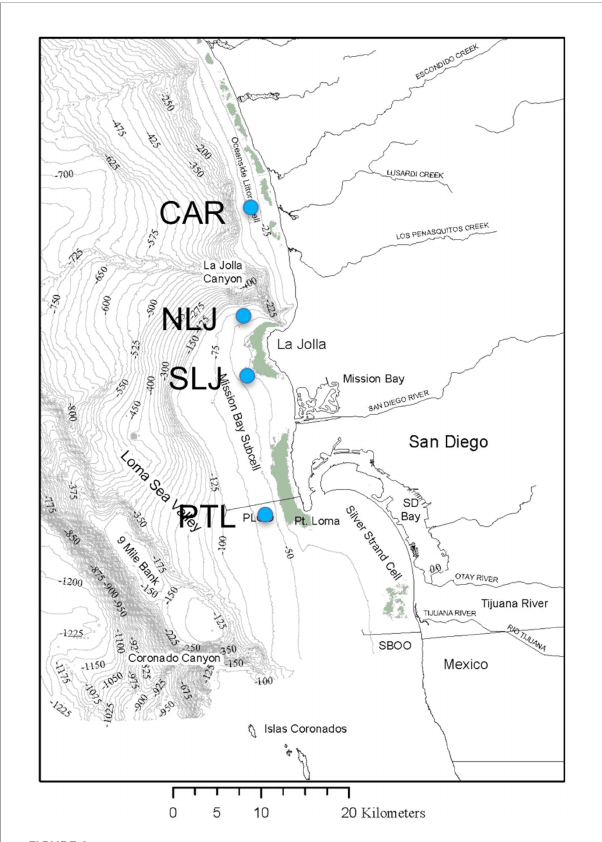
FIGURE 1 Study region along the coast of San Diego, CA, showing locations (blue circles) of recording temperature moorings deployed seaward of kelp beds off Cardiff (CAR), North La Jolla (NLJ), South La Jolla (SLJ), and Point Loma (PTL). Green tinted areas inshore of the study site markers indicate the maximum cover of kelp canopies recorded in aerial surveys 1983 through 2019 (MBC Aquatic Sciences,